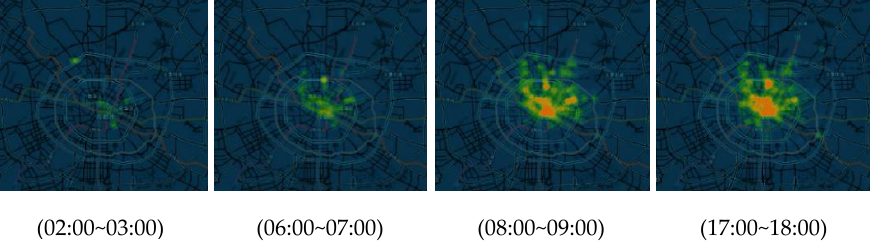
Figure 2. Demand heat map at different time periods in one day.